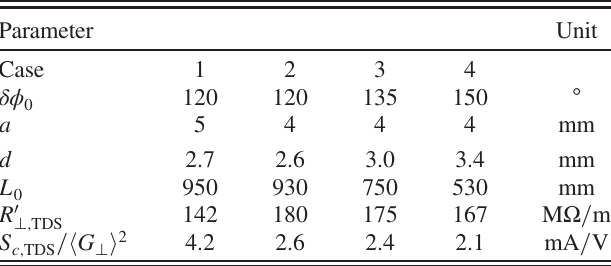
TABLE IV. TDS parameters for different aperture and rf phase advance per